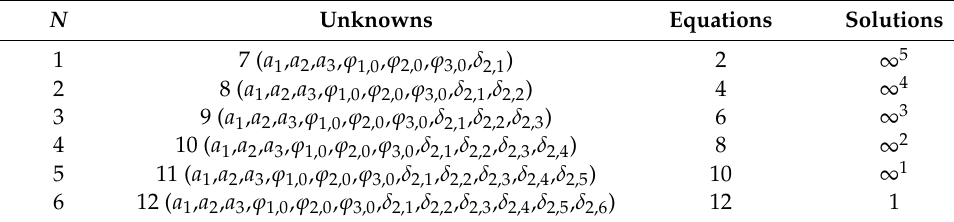
Table 1. Number of unknowns, equations and solutions for N displacements. N Unknowns Equations